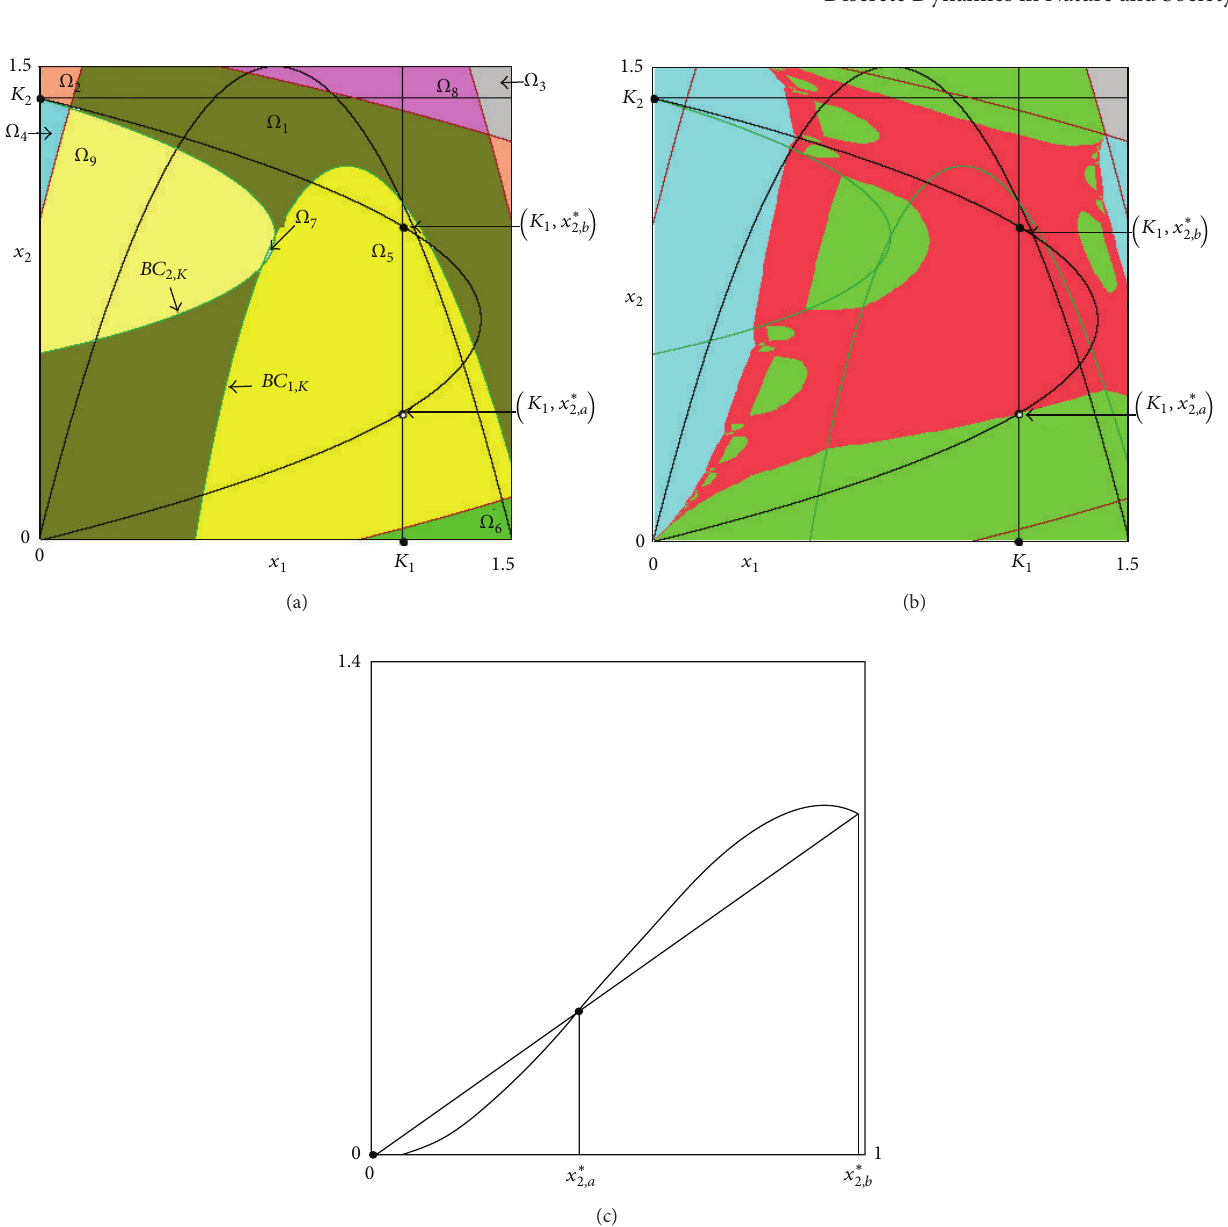
,0) (resp., 1 ,𝑥 ∗ ) . In the first two Panels, 𝐵𝐶 𝐵𝐶 1 1,𝐾 and 2,𝐾 2,𝑏